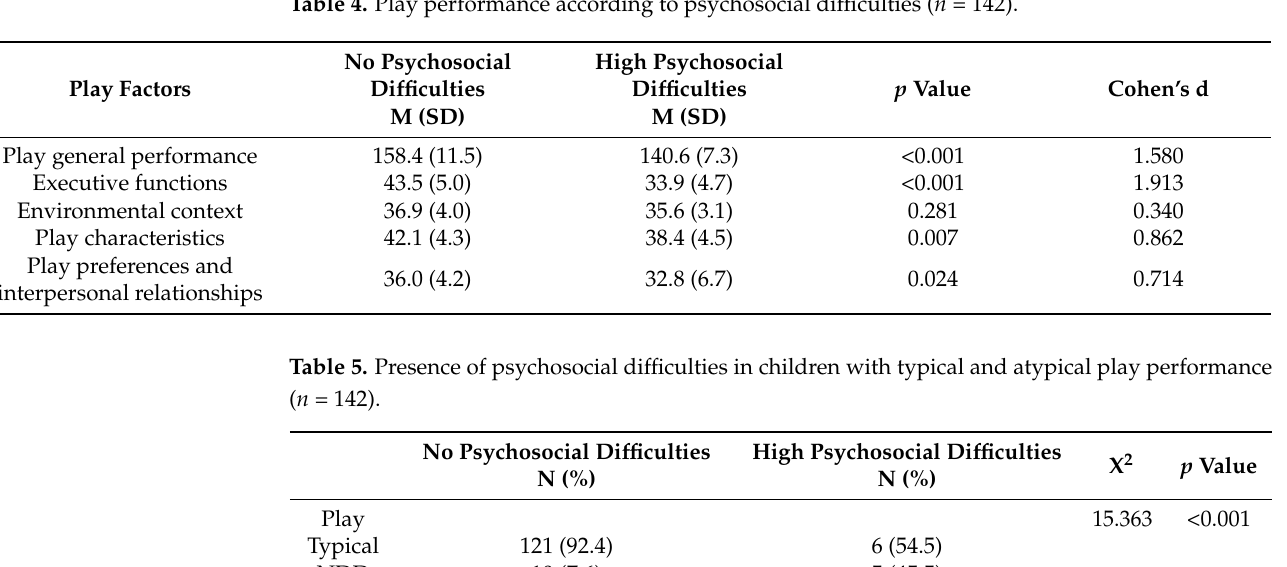
Table 4. Play performance according to psychosocial difficulties ( n = 142).